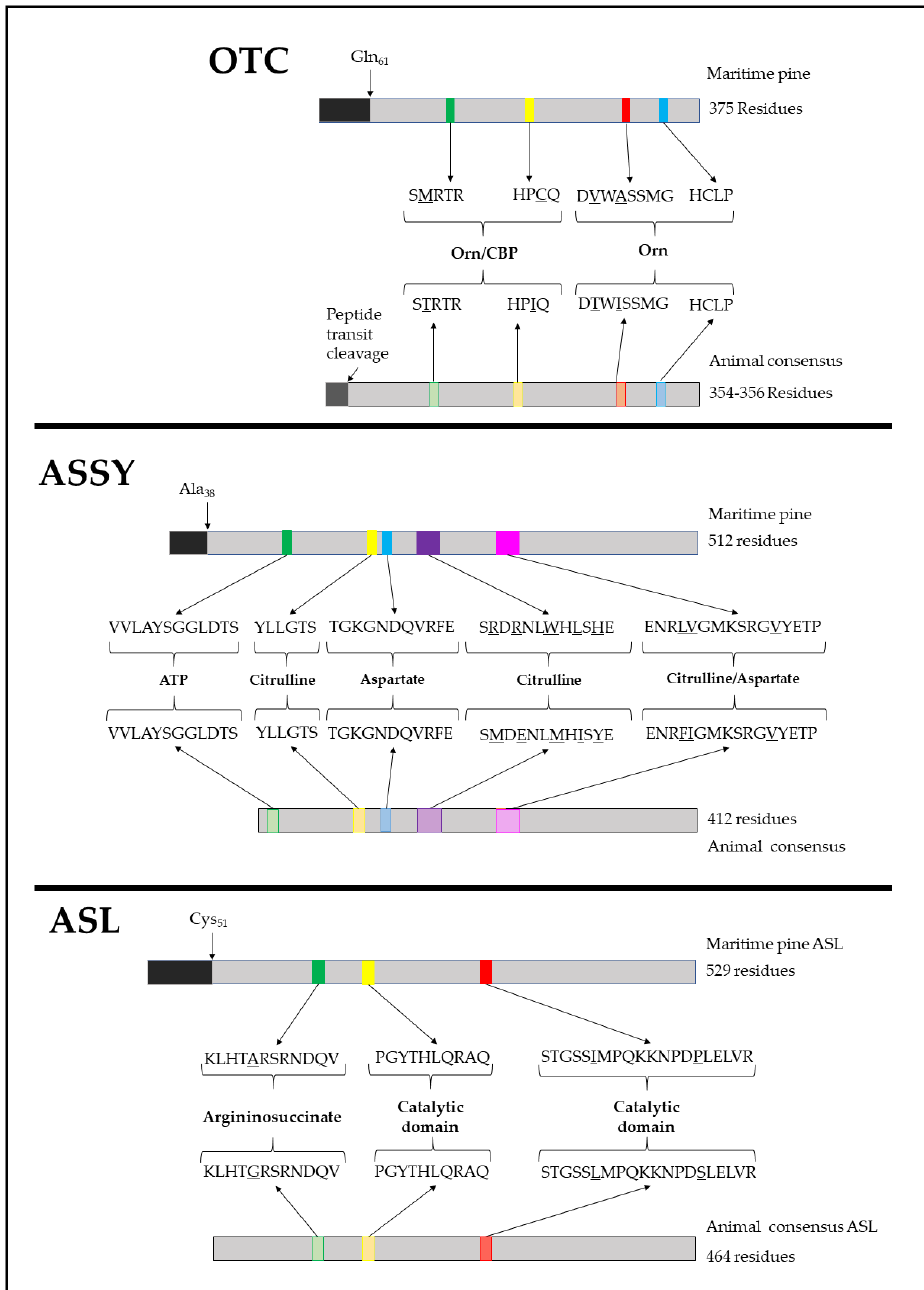
Figure 2. Schematic representation of OTC, ASSY and ASL primary structures. The distribution of conserved protein motifs and the primary structures of the proteins in both plants and animals are shown, with the conserved sequences and the punctual changes in some motifs (underlined). It is also highlighted the predicted cleavage site of the transit peptide using bioinformatics algorithms (TargetP 2.0). “Animal consensus” refers to the integration of sequences from Homo sapiens , Mus musculus , Rattus norvegicus , Anas platyrhynchos , Bos taurus , Ovis aries and Danio rerio . Complete alignment for these enzymes is shown in Figure S1.